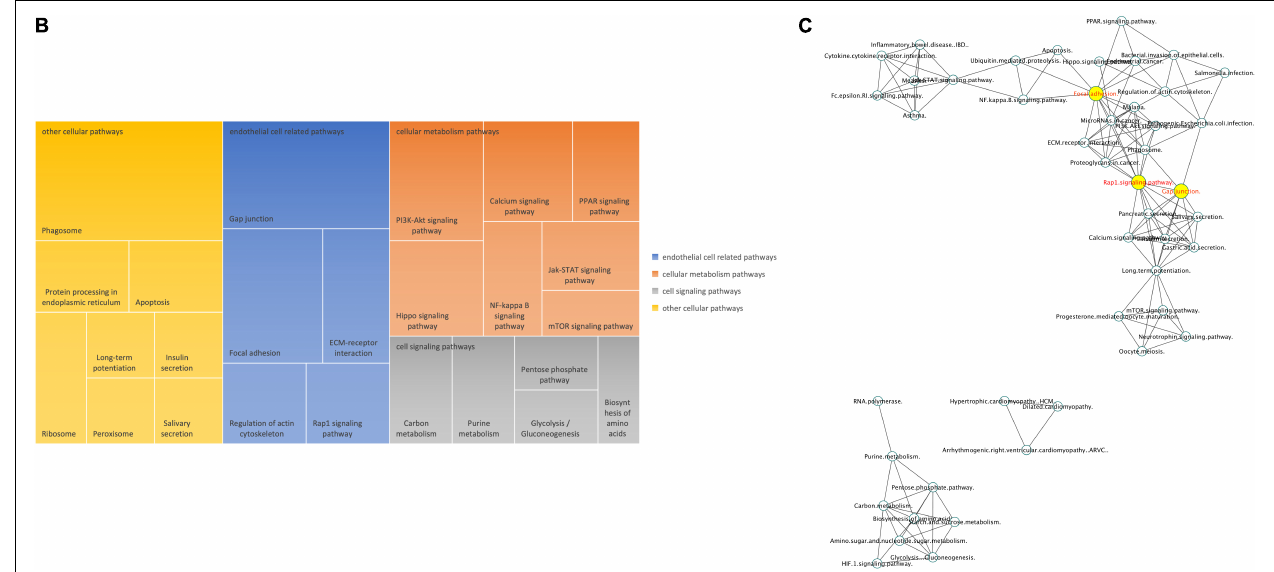
FIGURE 6 | LncRNAs expression mediated by γ -valerolactones treatment in human brain microvascular endothelial cells and their relationship with endothelial cell functions. HBMEC cells exposed to the mixture of gut metabolites ( γ -valerolactones) for 20 h and cells induced under stress by 4 h-incubation with TNF- α were used in microarray analysis to determine the differential expression of lncRNAs between groups. Subsequently, the lncRNAs targets were obtained from an analysis of databases (RNARNA, LncRRIsearch). An enrichment pathway analysis of miRNAs targets in GeneTrial was also performed. (A) Network of lncRNAs differentially expressed and their targets. A network built-in Cytoscape software. Hubs network components are highlighted by red squares. (B) lncRNA targets were overrepresented by genes coding for KEGG, Biocarta and Wiki modules associated with endothelial cell-related, cellular metabolism, cell signaling and other